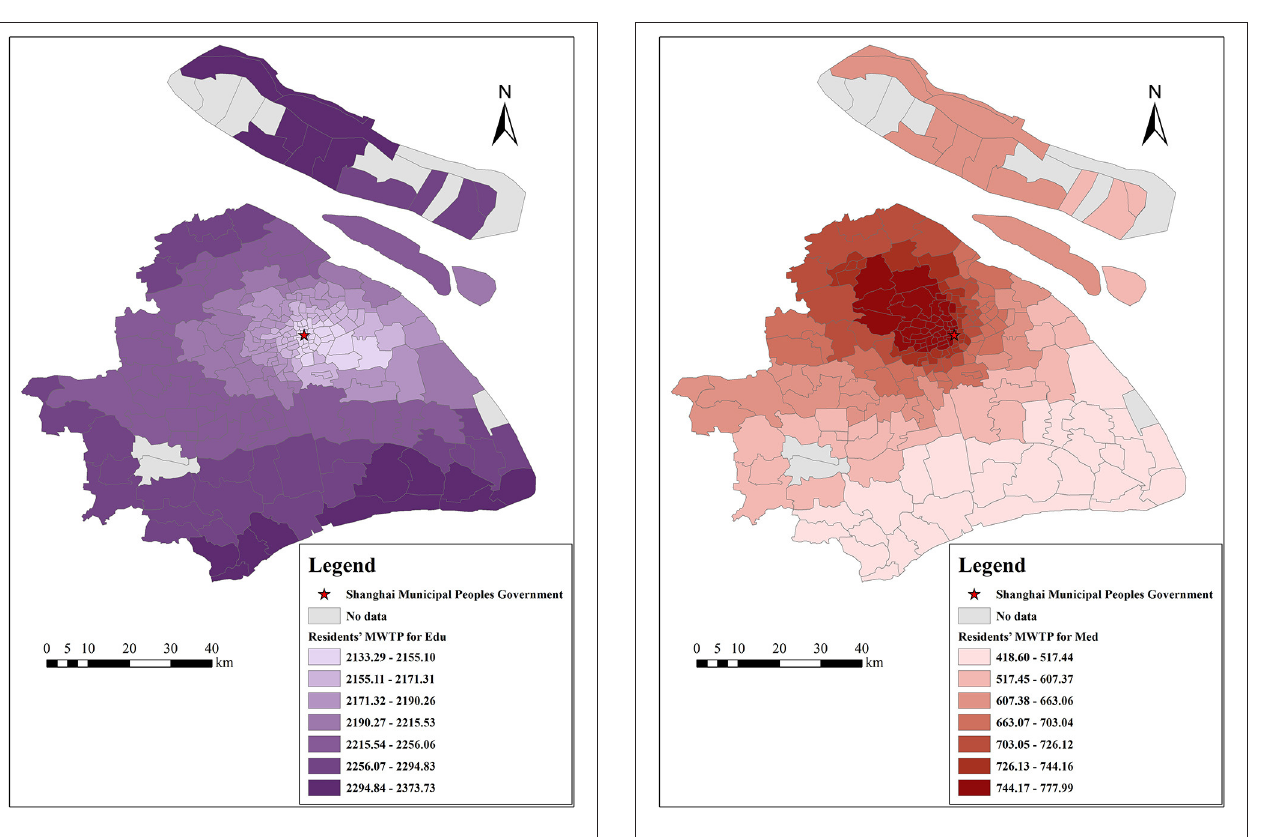
FIGURE 14 | The spatial heterogeneity of MWTP for educational services. FIGURE 15 | The spatial heterogeneity of MWTP for medical